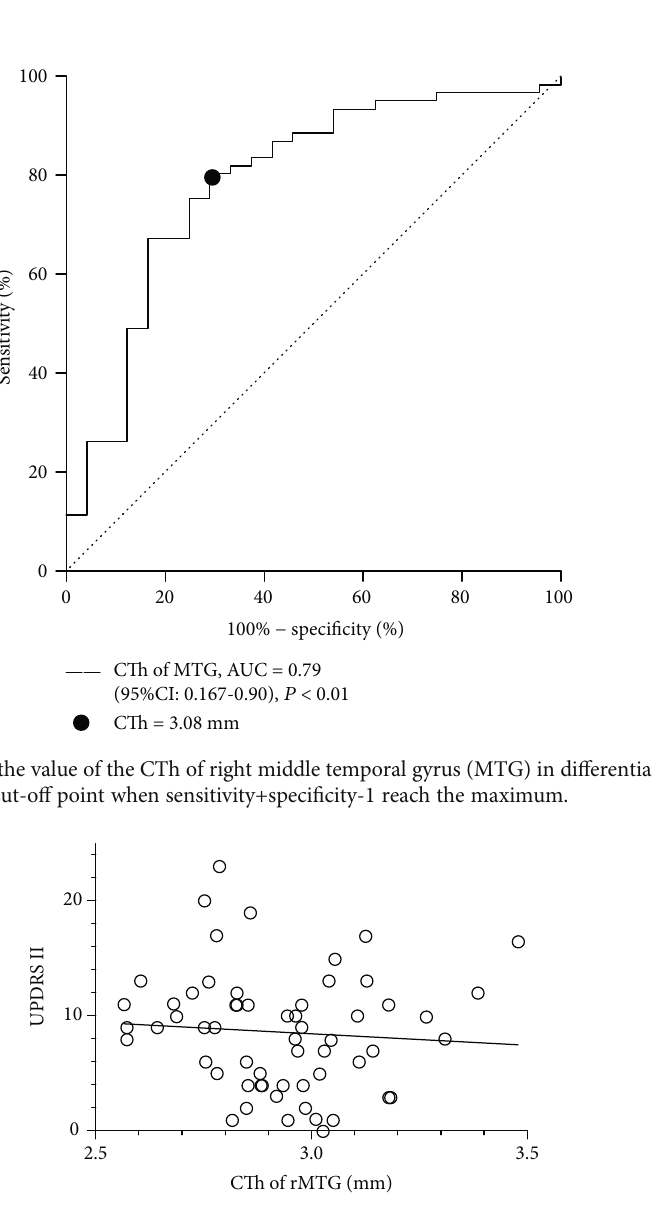
Figure 4: CTh of right middle temporal gyrus (MTG) showing negative correlation with UPDRS part II score in PD patients after correcting the in fl uence of age and disease duration (P < 0.05).